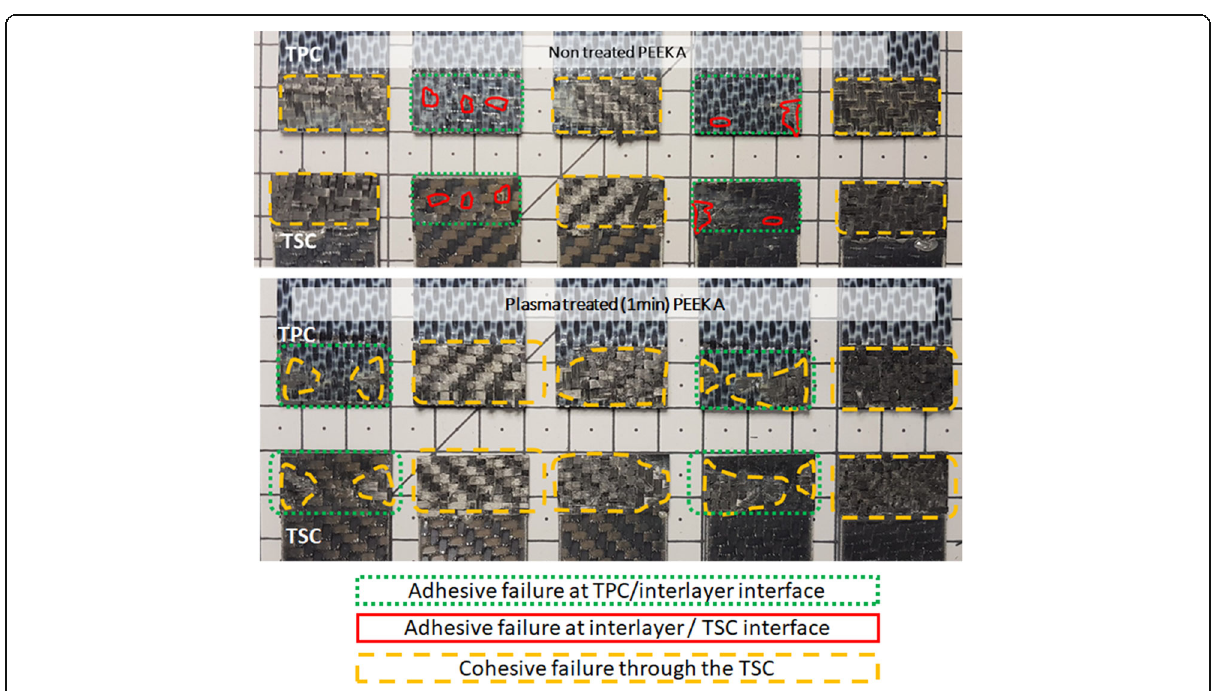
Fig. 14 Failure mode analysis on nontreated and plasma treated PEEK A interlayer welded joints